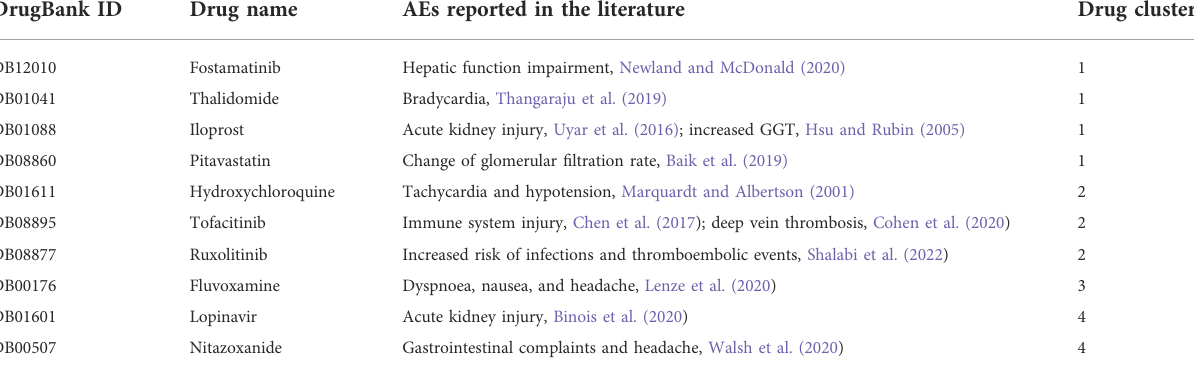
TABLE 3 Summary of 10 representative COVID-19 drugs in the clinical trial stage. Information on 10representative COVID-19 drugs which are in the clinical trial stage is shown, including DrugBank ID, typical AEs with literature support, and the drug cluster to which each drug belongs. DrugBank ID